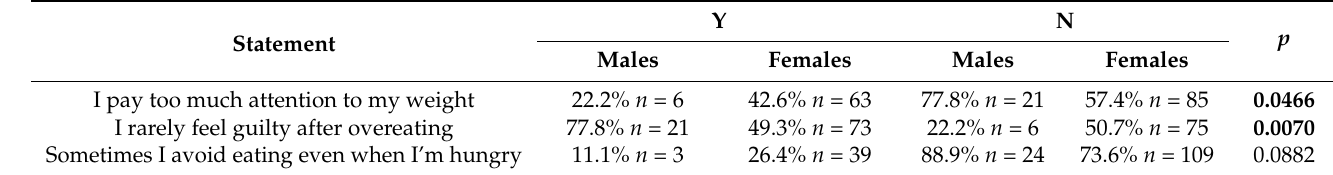
Table 9. The differences in dietary restrictions results between males and females.